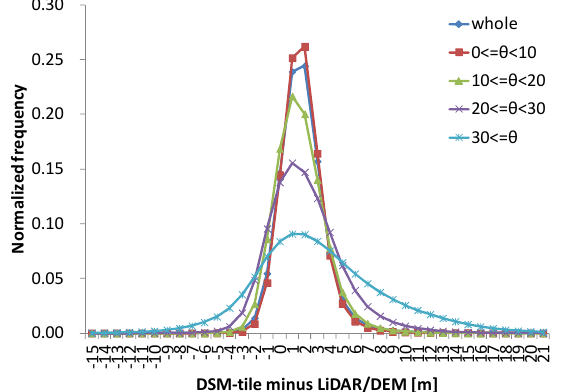
Figure 7. Histogram of height differences for different ranges of slope angles as well as for whole data. The depicted difference-range corresponds to +/-3  from the  for the distribution in the slope range of ‘30<= 